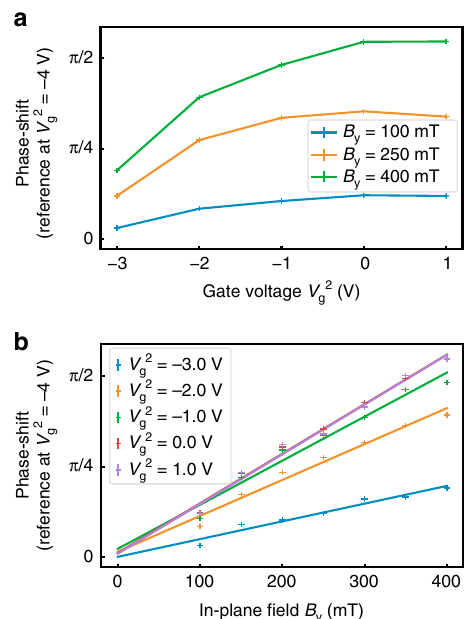
Fig. 4 Tuning anomalous phase shift using gate voltage and in-plane magnetic fi eld. Evolution of the phase shift in JJ2 as a function of the gate voltage ( a ) and of the applied in-plane fi eld along y ( b ). The phase shift Δϕ 0 is measured between the oscillations at a given value of V ones at − 4 V used as reference. In b the solid lines corresponds to linear fi ts to the measured phase